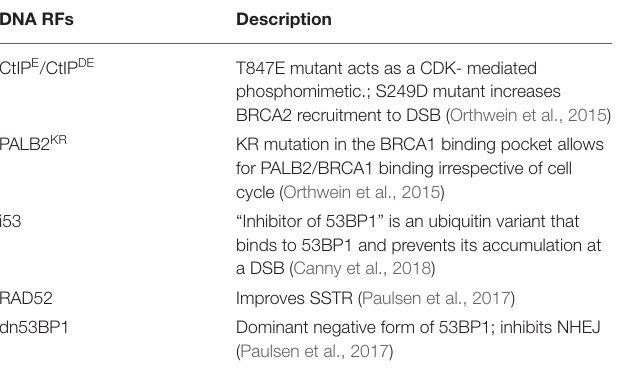
TABLE 1 | Panel of DNA repair factors assessed in this